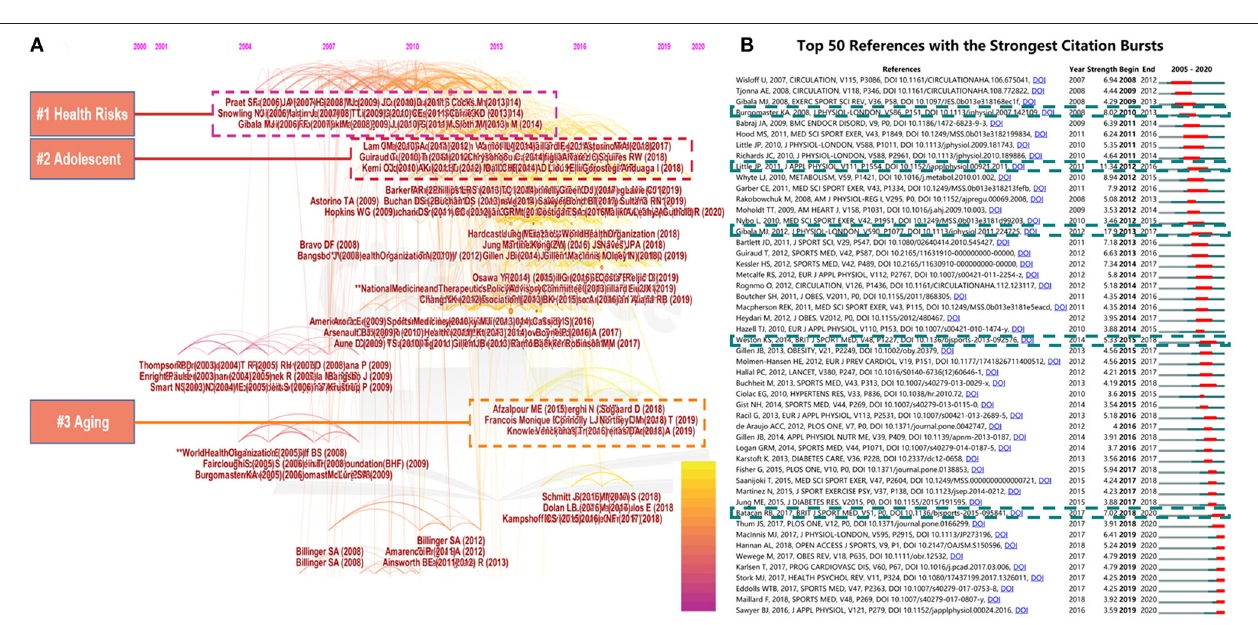
FIGURE 6 | The timeline view map based on the reference co-citation analysis in the HIIT-HP field (A) ; top 50 references with the strongest citation burst in the HIIT-HP field (B)